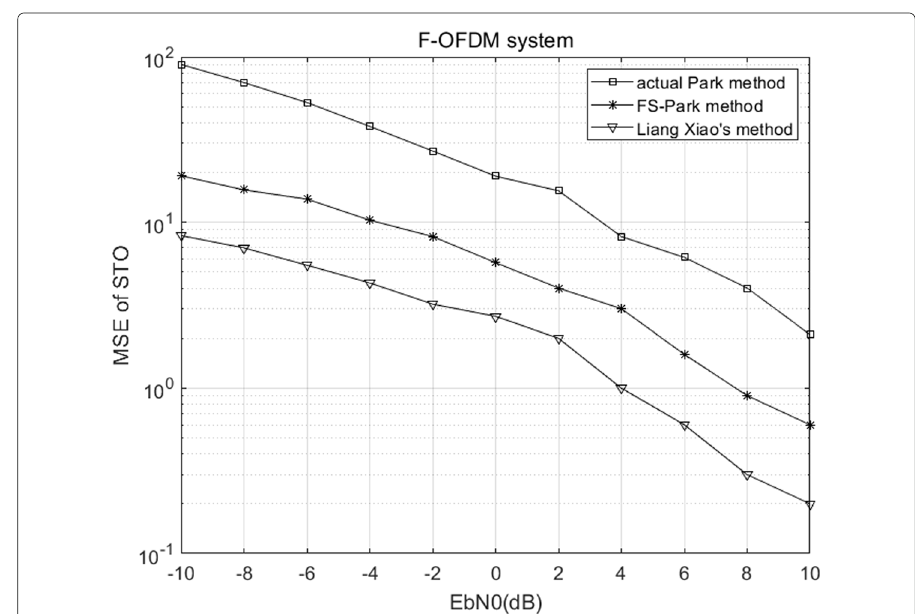
Fig. 10 MSE performance of various estimators with different STO